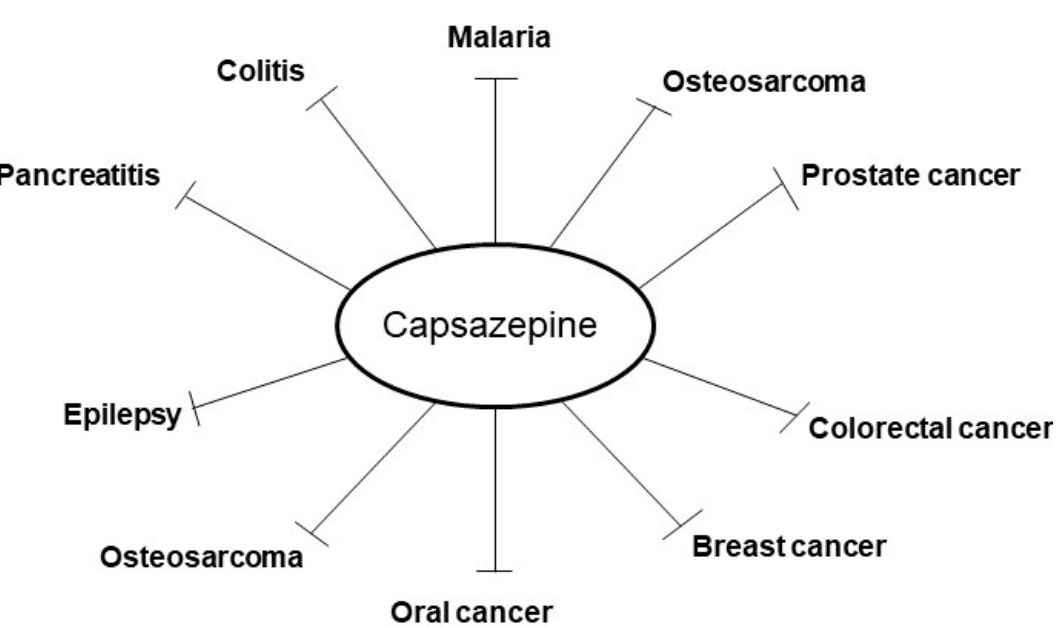
Figure 1. The chemical structures of capsaicin and capsazepine.